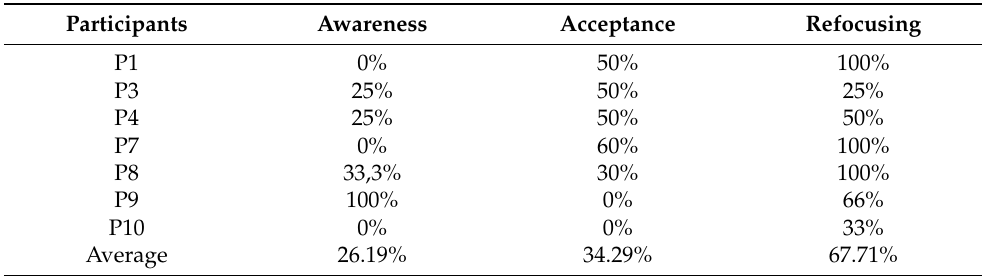
Table 6. Percentage of data exceeding the median recorded in MIS subscales from baseline to intervention phase for the seven participants.